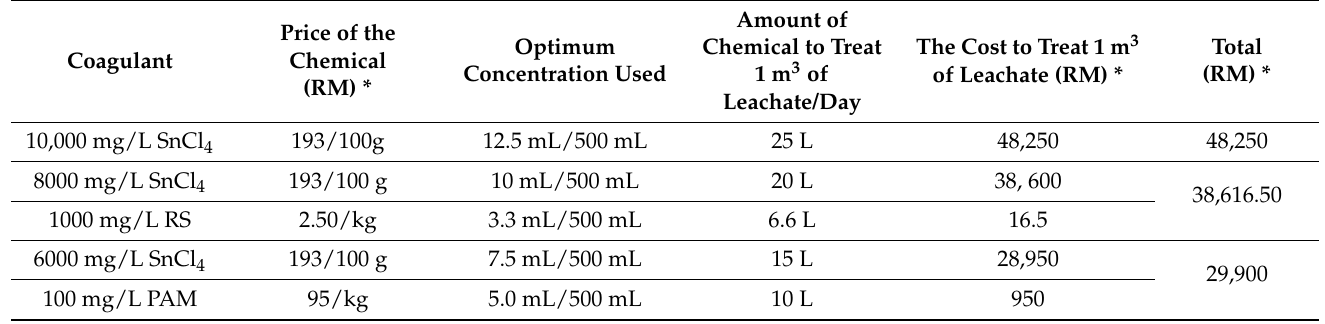
Table 4. Cost estimation for SnCl 4 and the coagulant aids (RS and